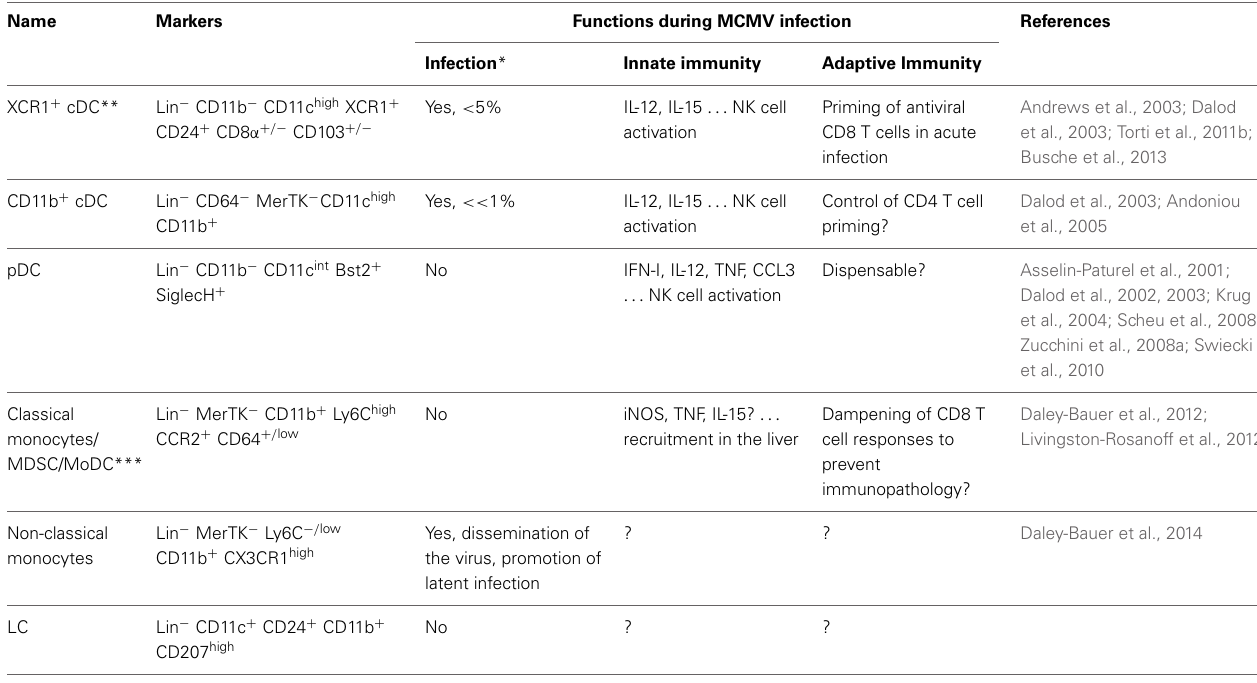
Table 1 | Nomenclature, phenotype and in vivo functions of monocyte and DC subsets during MCMV